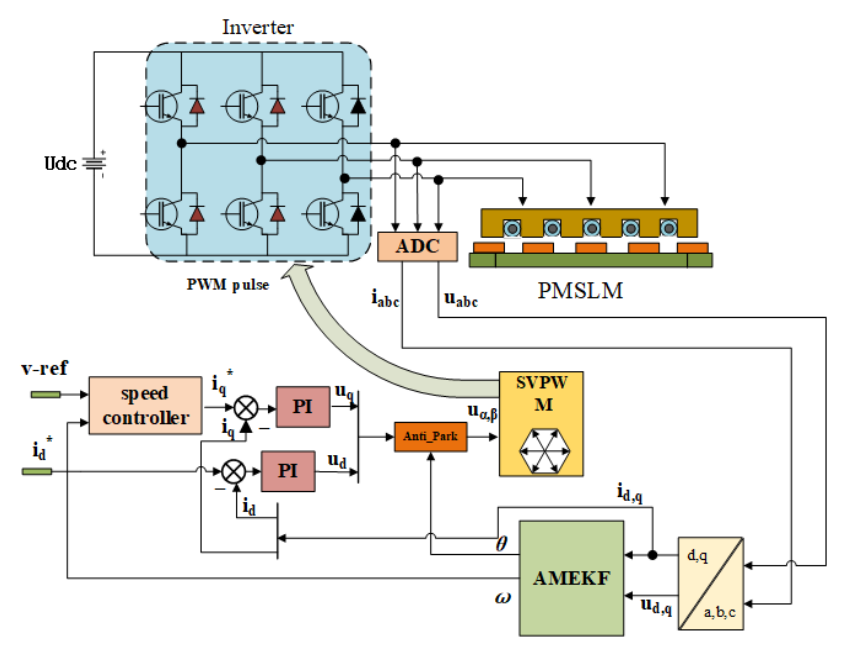
Figure 3. PMSLM vector control structure based on AMEKF.